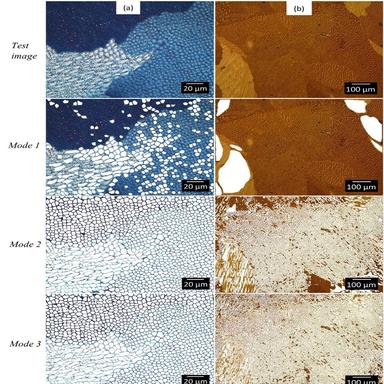
Results showing the sensitivity of prediction to sliding window size (Mode 1: a single-window covering the entire input image dimension, Mode 2: a fixed window of 320320 pixels, and Mode 3: auto-adjusting window). Test image (a) represents small cells relative to image dimension and image (b) represents extremely small cells.